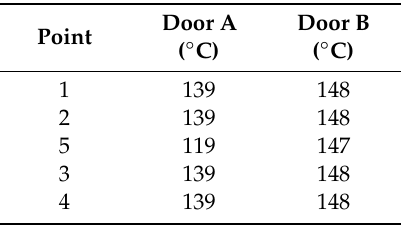
Figure 8. Transversal temperature profiles calculated at the final stage of the fire test (60 min) using unsteady-state FEM model: comparison of door A and door B. Table 4. Calculated temperatures at the final stage of the fire test (60 min) on the door A and B. Ambient temperature equal to 28 ◦ C in this